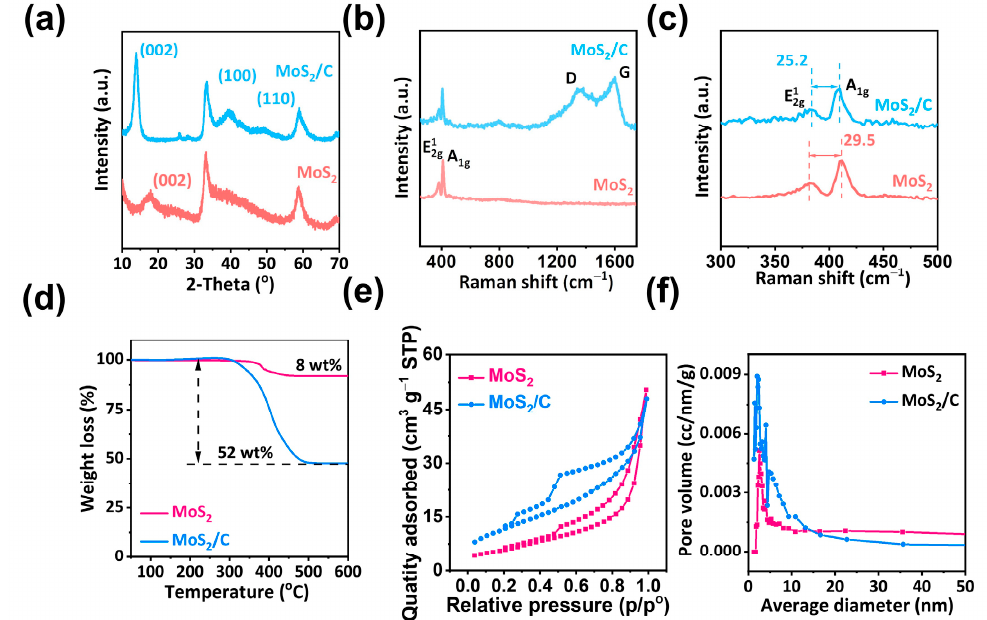
and ( f ) pore-size distribution curves of the MoS 2 /C and MoS 2 , respectively.